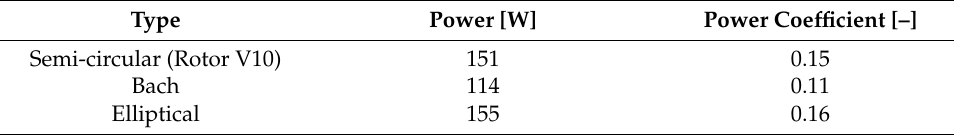
Figure 9. Definitions of design parameters for Bach and elliptical rotors. Tables 3 and 4 summarize the performance and efficiency of the Bach and elliptical types, respectively, consequent to changes in the design parameters under conditions with TSR value of 0.6. In the case of the Bach type, the blade curvature increased as a decreased and negative torque did not occur when a < 0.22 m. As θ decreased, the blade curvature decreased, and the difference between the minimum and maximum torque increased. Among all the cases, the BachV5(a = 0.3D, θ = 135°) geometry showed the lowest difference between the minimum and maximum power and the highest average power generation. In the case of the elliptical type, because the blade geometry is similar to that of the semi ‐ circular type, with a decrease in a, both power and efficiency decreased as well. Con ‐ versely, the power and efficiency increased in correspondence with an increase of θ due to increase in the curvature of the rotor; however, the trend reversed when θ exceeded 40° at which point the performance declined. The maximum efficiency attained with the el ‐ liptical geometry was 18%, and the average power was the highest at a = 0.41D and θ = 40° (EllipticalV8).